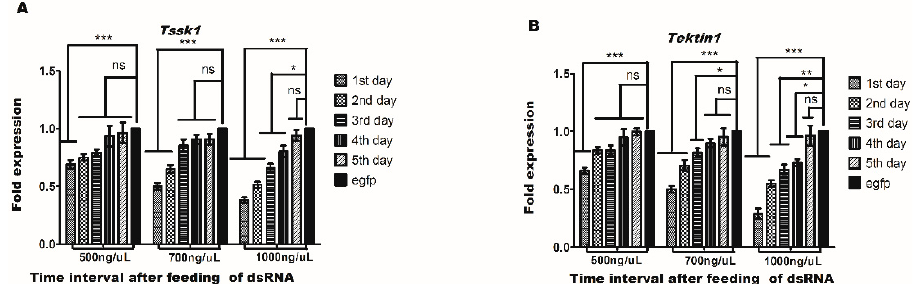
Figure 4. Gene silencing of Tssk1 and Tektin1 gene in males of B. dorsalis caused by oral feeding of different concentrations of their dsRNAs. The control was treated with ds-egfp. (A) Fold change in Tssk1 gene transcription. (B) Fold change in Tektin1 gene transcription. One-way ANOVA was used to analyze the results ( p < 0.0001, Tukey test) .